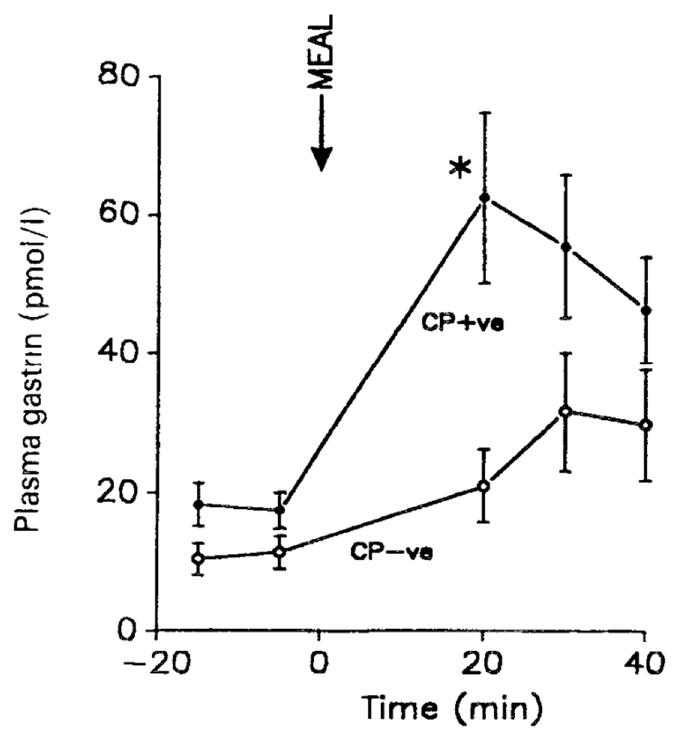
Figure 5. Meal-stimulated serum gastrin concentrations in duodenal ulcer patients with positive (CP+ve) or negative (CP–ve) biopsy urease tests for Helicobacter pylori . The arrow indicates the onset of the meal. From Levi et al. [18] with permission.